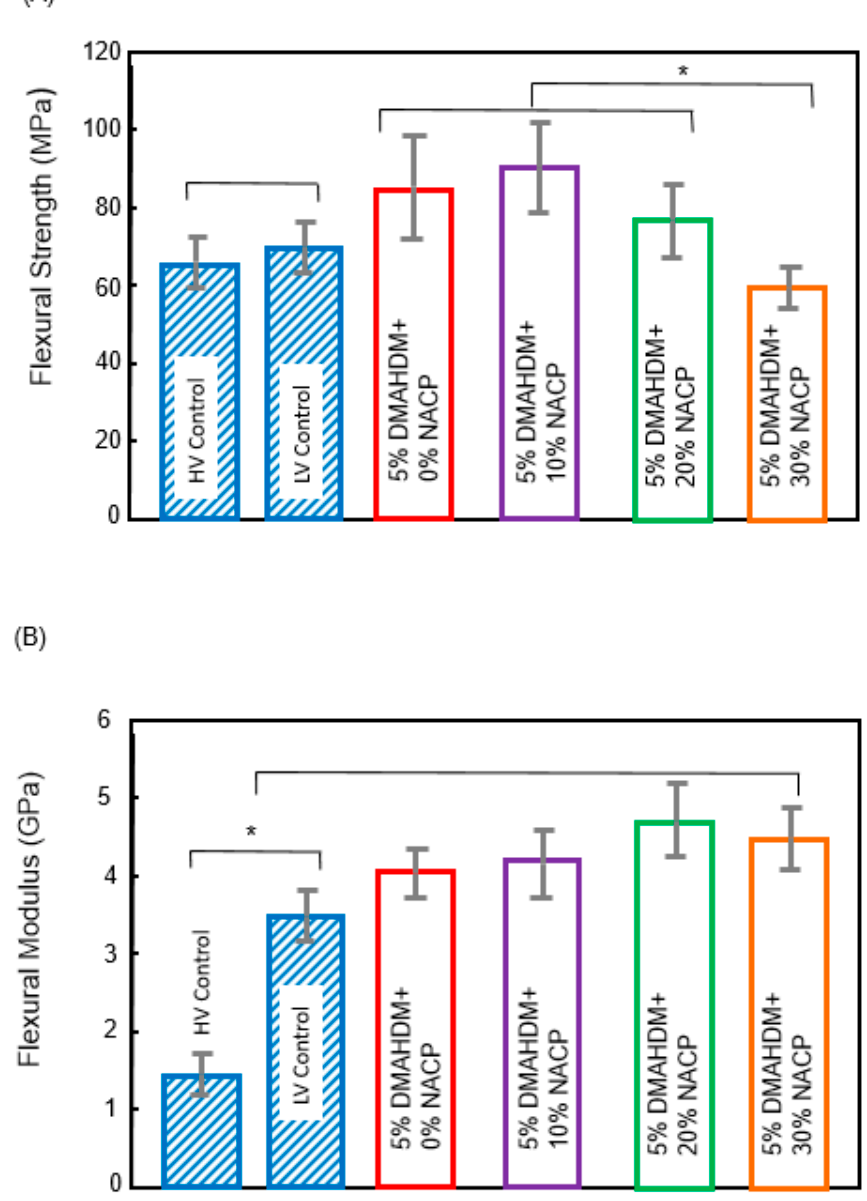
Figure 2. Bar graphs of ( A ) flexural strength and ( B ) flexural modulus (Mean ± SD; n = 8) of resin-based sealants. The asterisk means that there was a statistically significant difference between the groups.